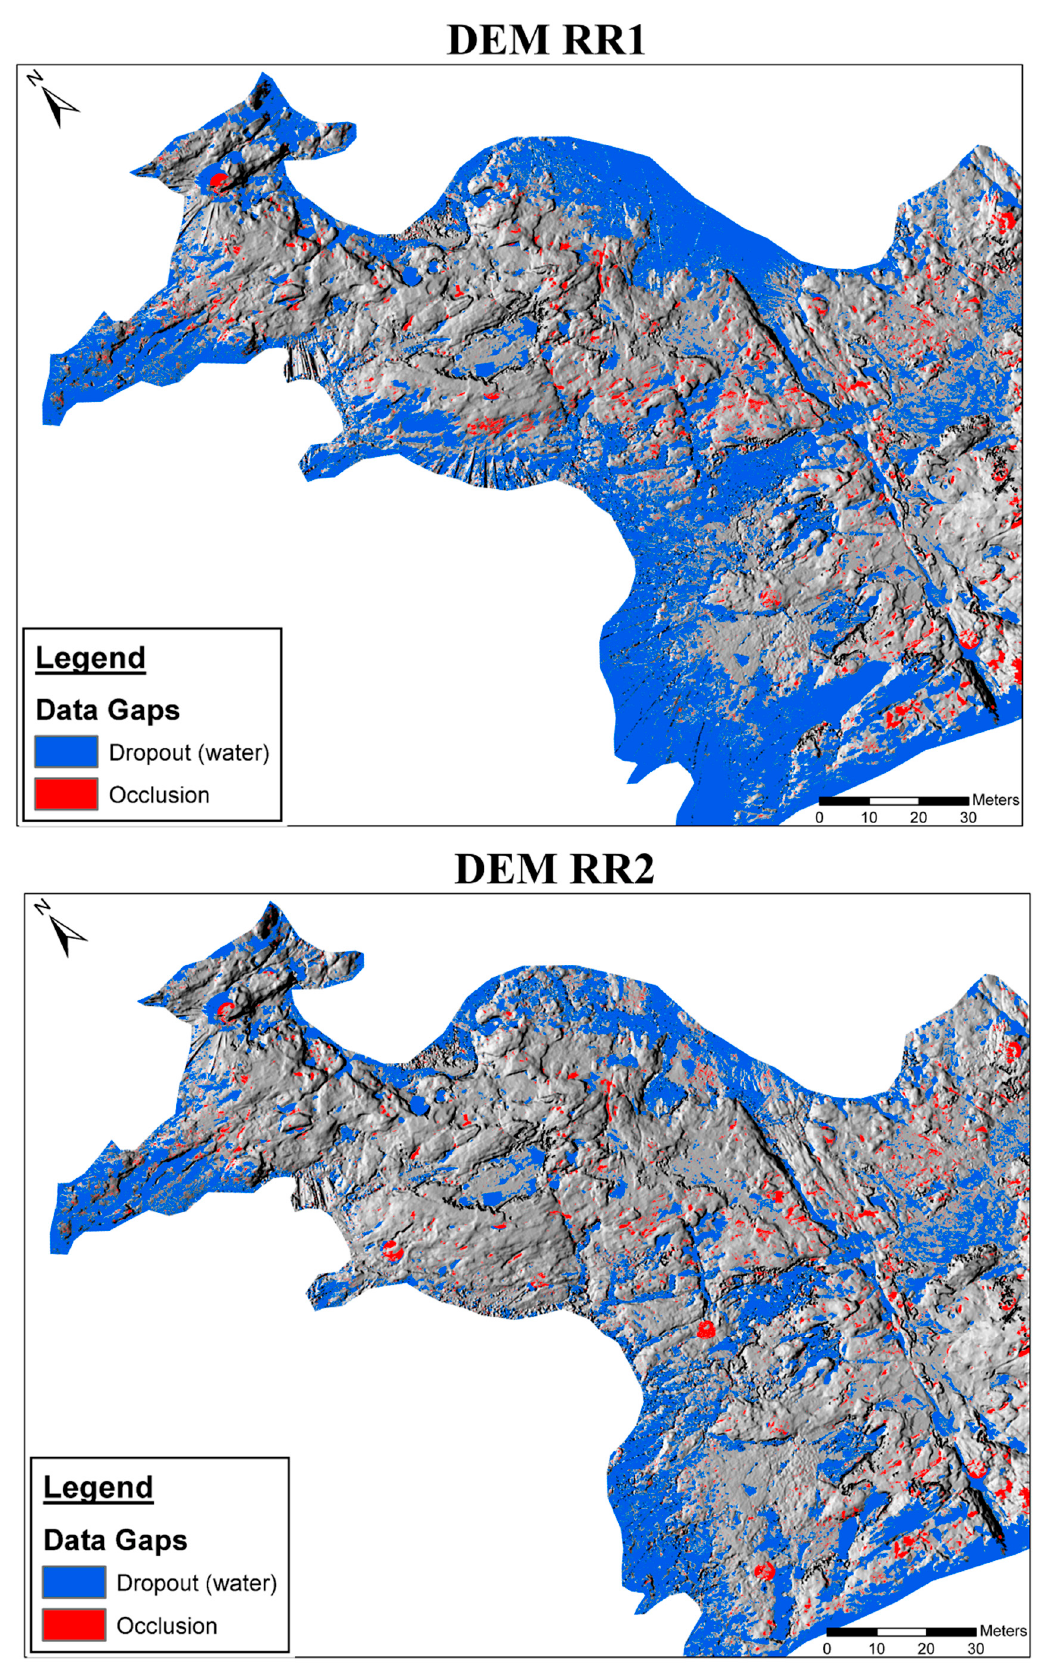
Figure 12. Clipped data classification results for DEMs RR1 (top) and RR2 (bottom).